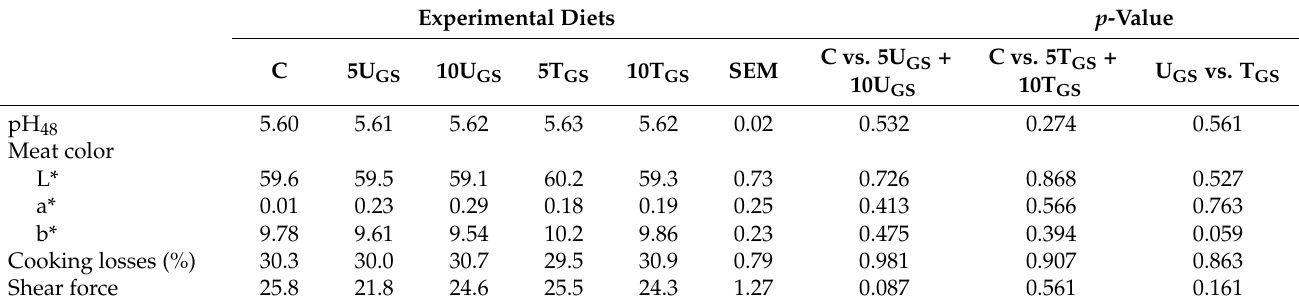
Table 7. Effect of the experimental diets on parameters of meat quality of longissimus muscle ( n = 10). Experimental